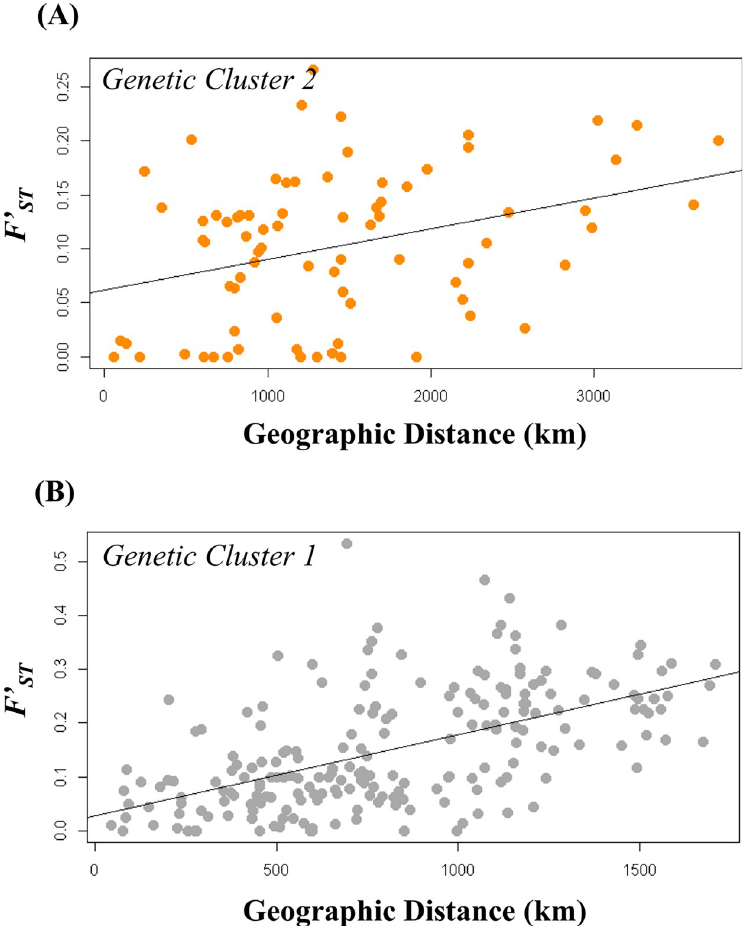
Fig 4. Isolation by distances (IBD) of genetic clusters 2 and 1 in the B . fervidus species complex. (A) Isolation by Distance Plot: Linearized F ST between pairs of genetic cluster 2 populations compared to geographic distance. (B) Isolation by Distance Plot: Linearized F ST between pairs of genetic cluster 1 populations compared to geographic